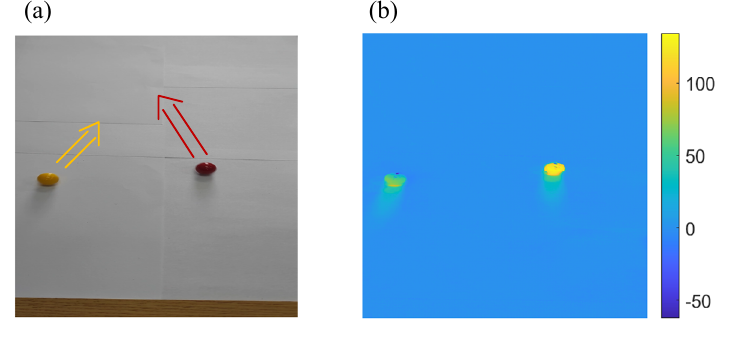
Figure 9. Experiment scene: ( a ) is the 240th frame in the video, and ( b ) is the image of 240th frame with background